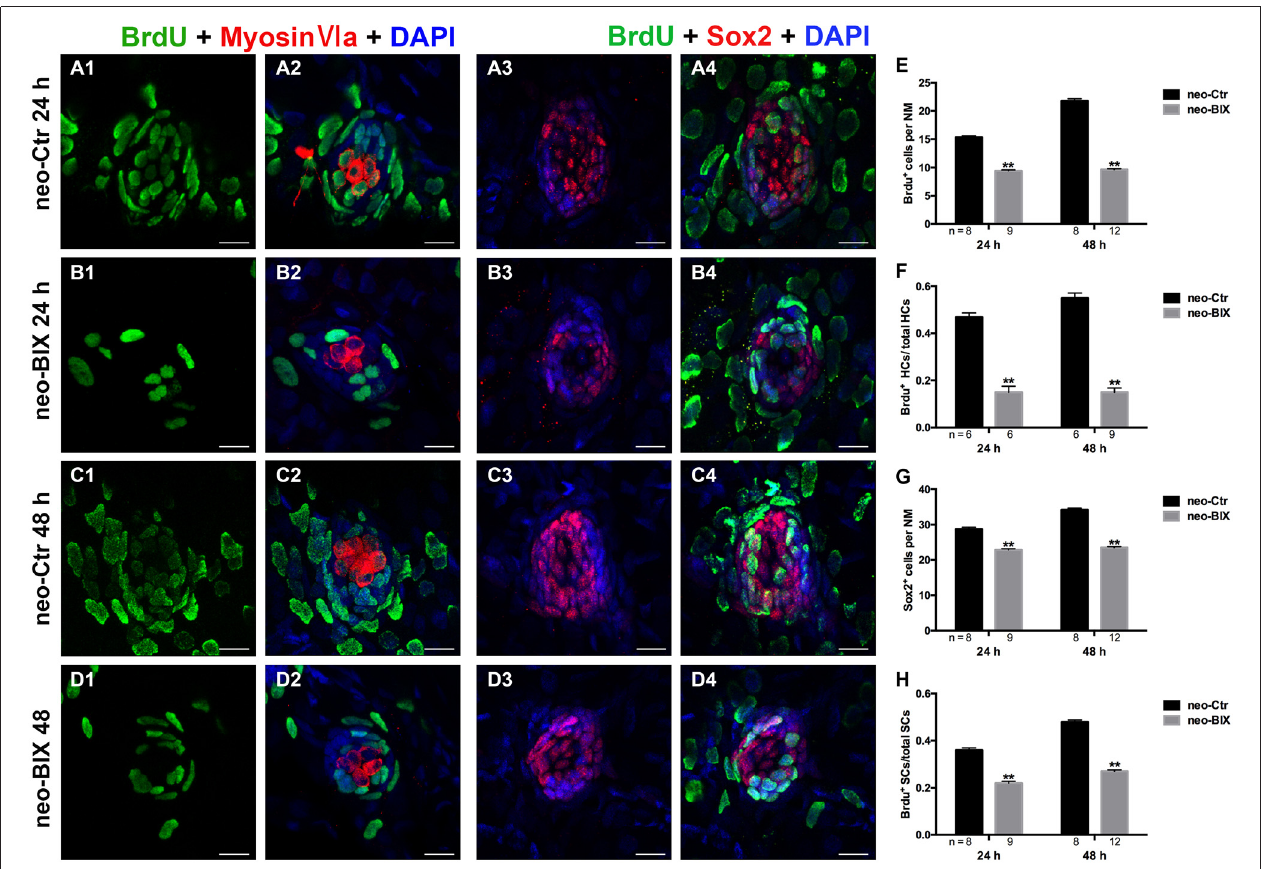
FIGURE 5 | BIX01294 significantly suppresses cell proliferation and induces reduced supporting cell (SC) production . We treated larvae at 5 dpf with neomycin and monitored cell proliferation with or without BIX01294 over the next 2 days. (A1–D2) The BrdU antibody shows dividing cells (green) in the NMs of the zebrafish lateral line, and HCs are stained with Myosin-VI (red). Scale bars = 10 µ m. (A3–D4) Lateral line SCs are stained with Sox2 antibody (red), and nuclei are stained with DAPI (blue). The BrdU antibody shows dividing cells (green) in the NMs of zebrafish. Scale bars = 10 µ m. (E) BrdU + cells were counted in control and BIX01294-treated larvae at 24 h and 48 h after neomycin damage for 1 h. (F) Quantification of the ratio of BrdU + HCs in control and inhibitor-treated larvae at 24 h and 48 h after neomycin incubation for 1 h. (G,H) The number of SCs and quantification of the ratio of BrdU + SCs in control and BIX01294-treated larvae at 24 h and 48 h after neomycin incubation for 1 h. Bars are mean ± SD, and n = total number of embryos. ∗∗ p <